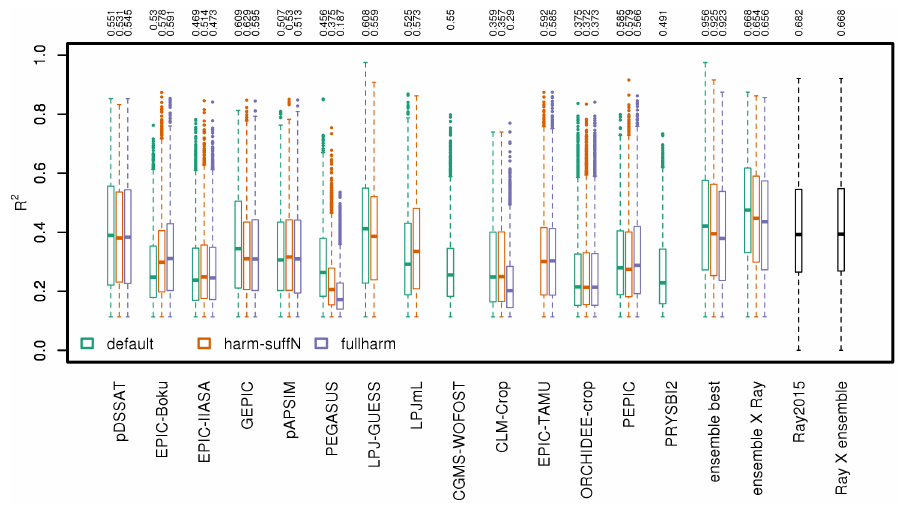
Figure 11. Box plot of R 2 distribution for each GGCM-harmonization setting for maize. Boxes span the interquartile range (25–75 per- centiles); whiskers expand to the most remote value within 1.5 times the interquartile range. Values outside this range are considered outliers and are depicted as dots. The “ensemble best” shows the GGCMI skill-based (correlation coefficient) ensemble, “ensemble X Ray” is the same but only for those pixels where, and both are not independent from FAO national data also report significant correlations, “Ray2015” is the distribution of values as published by Ray et al. (2015), “Ray X ensemble” is as Ray2015 but only for the area where also the GGCMI ensemble reports significant correlation coefficients. The distribution is weighted by production, following the Ray2012 data set. Numbers at the top describe the fraction of the total harvested area for which significant correlations could be found, which ranges between 96% (ensemble best, default), 63% and 19% for the individual GGCMs, and 68% for Ray et al.